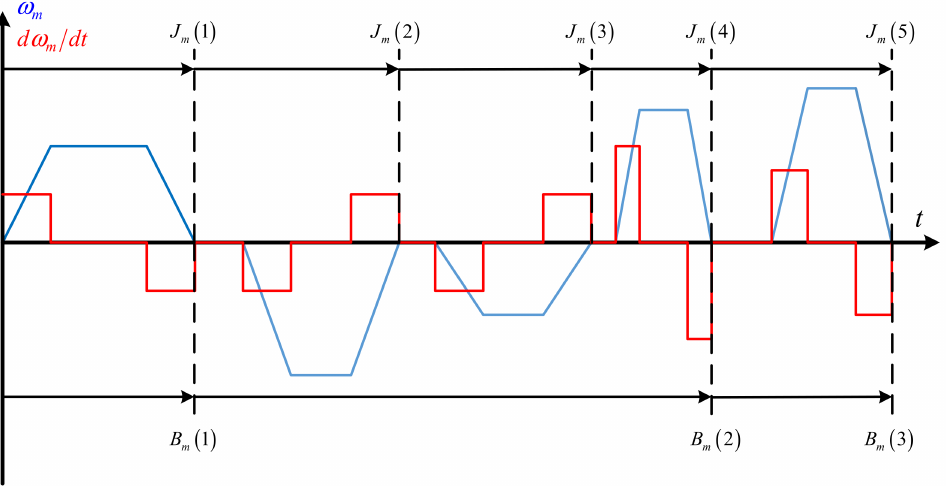
Figure 3. Schematic diagram of the proposed update sampling